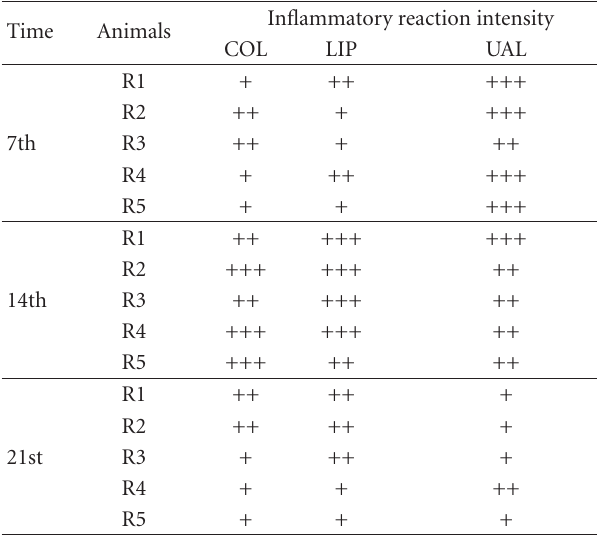
Table 1: Assessment of the intensity of the inflammatory infiltrate in the COL (collagen group), PHO (collagen/liposome group), and UAL (collagen/liposome/usnic acid group), in 7, 14, and 14 days after burning